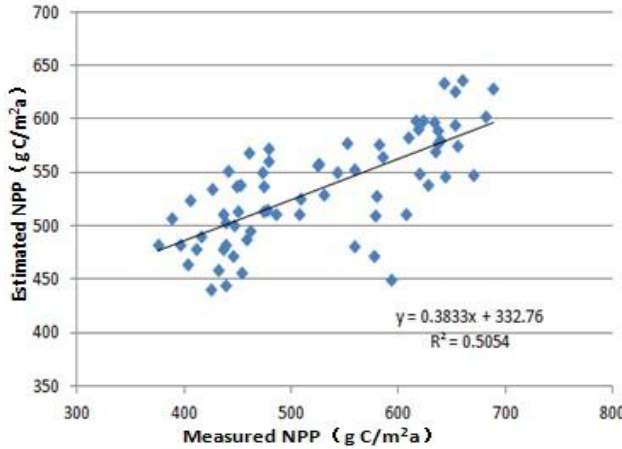
Figure 8. Comparison of the values between the measured NPP and estimated NPP.